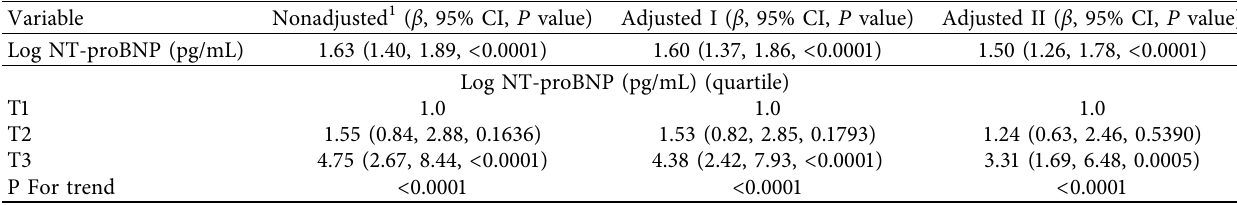
Table 3: Relationship between Log NT-ProBNP and MACE in different models.